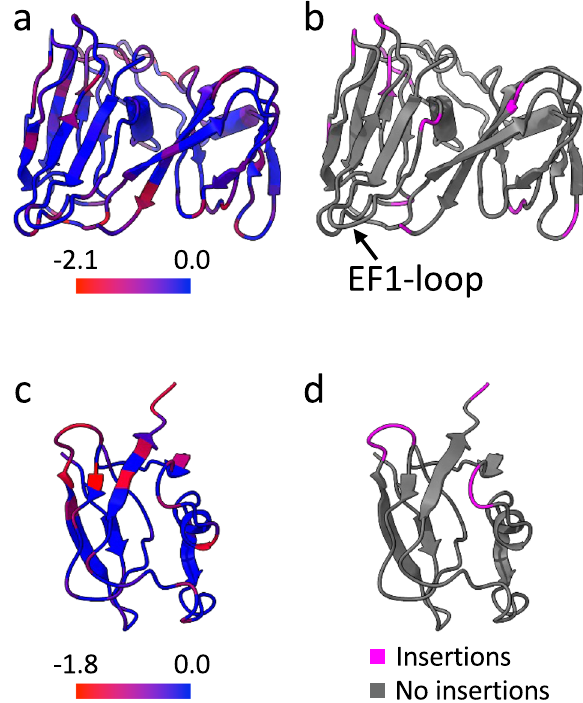
Fig. 5 | Mapping of Φ CjT23-like prophage sequence variation. a Sequence conservation 72 (score – 2.12 – 2.26) determined by multiple sequence alignment of Φ CjT23-like prophage sequences ( N =21) and Φ CjT23 major capsid protein (MCP) mapped per residue on the Φ CjT23 MCP structure. b The same view as in a with residues surrounding insertions highlighted in pink. c Sequence conservation (score – 1.84 – 2.36) determined by multiple sequence alignment of Φ CjT23-like prophage sequences ( N =8) and Φ CjT23 spike protein N-terminal domain. d The same view as in c with residues surrounding insertions